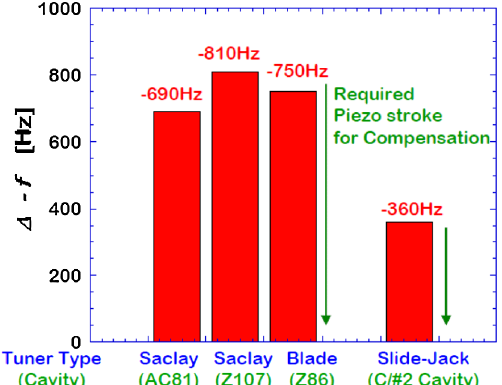
FIG. 22. (Color) Comparison between Lorentz-detuning fre- quencies ( (cid:3) (cid:1) f ) of different cavities with different tuner sys- tems under the normalized operational condition with E 31 : 5 MV = m and flattop pulse width of